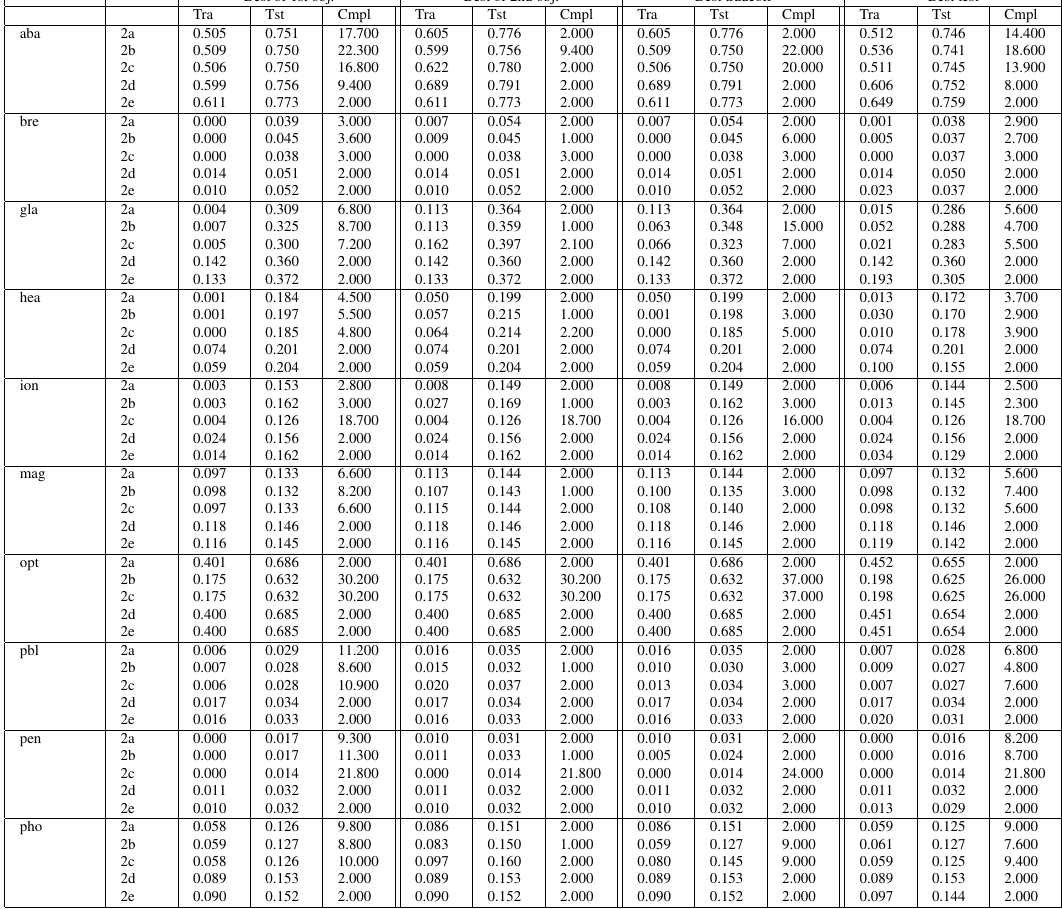
Table 9: Statistics of four single solutions selected from the Pareto fronts. Bestof1stobj.